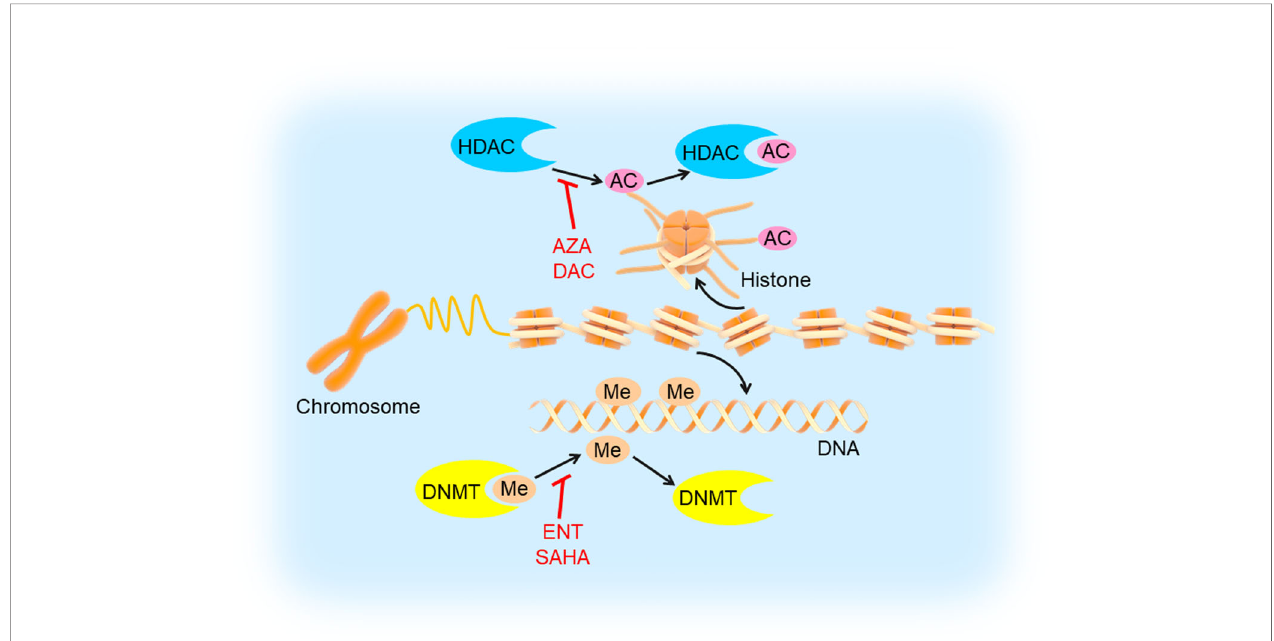
FIGURE 5 | DNA methylation and histone deacetylation inhibition in TNBC. DNA is methylated by DNMT and histone is deacetylated by HDAC, which could be inhibited by DNMTi ’ s (entinostat/ENT, suberoylanilide hydroxamic acid/SAHA) and HDACi ’ s (5-azacytidine/AZA, decitabine/DAC), respectively. This would induce tumor cell apoptosis and inhibit angiogenesis, cell migration and